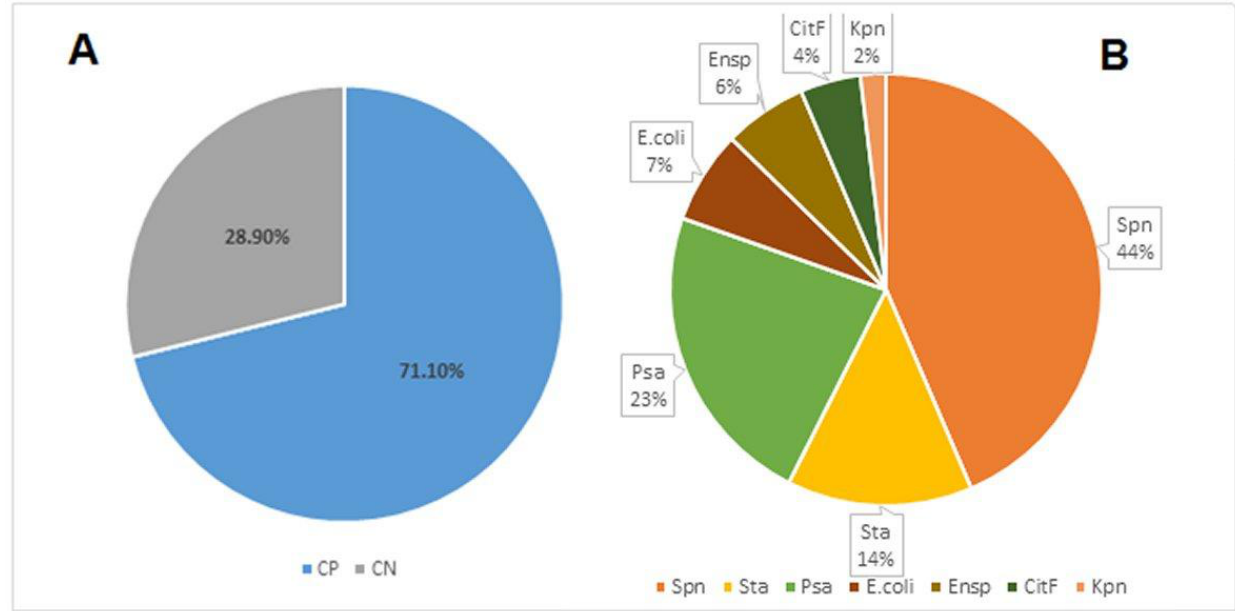
Figure 1: Detection and identification of bacterial pathogens isolated from 1,110 patients with URTIs. Fig 1A shows the rates of culture positive and culture negative specimens. Fig 1B shows the proportion of different bacterial strains among culture positive